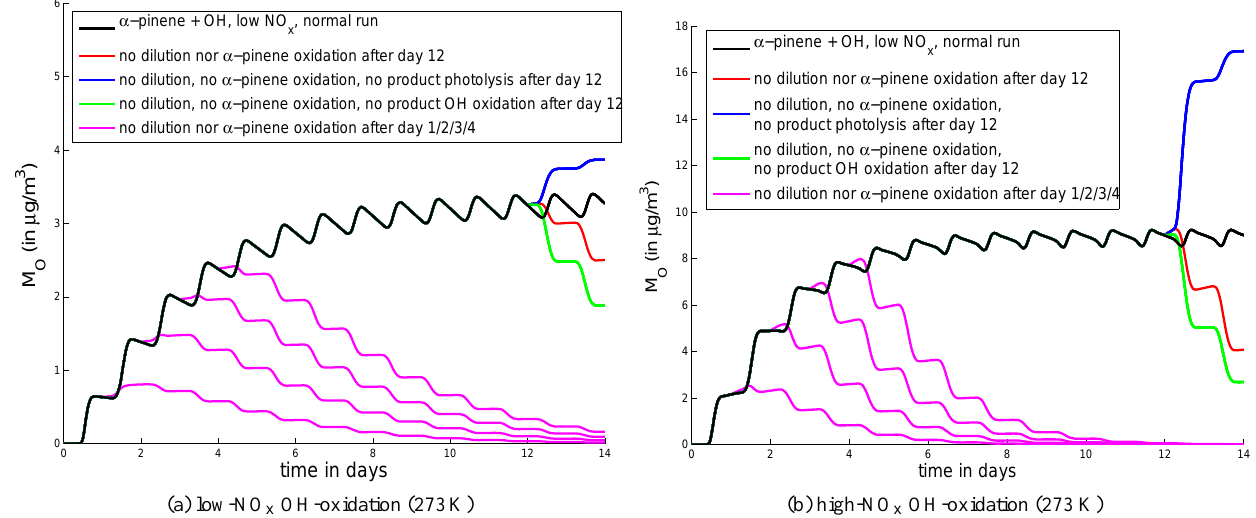
Fig. 3. Full BOREAM model SOA mass loading M O , for the low-NO x and high-NO x OH-oxidation scenario, at 273K, as a function of time (black). α -pinene concentrations undergo a diurnal variation between 0.002ppb at night and 0.01ppb as the maximum during the day for low-NO x , and between 0.02 and 0.1ppb for high-NO x . When M O has reached a stable equilibrium level, a number of tests are conducted, starting after day 12, to estimate the impact of photo-chemical reactions on the condensable products without further α -pinene oxidation and product deposition. Similar tests show the effect of photo-chemical reactions at earlier points in the ageing scenario, starting after 1, 2, 3 or 4 days (magenta).